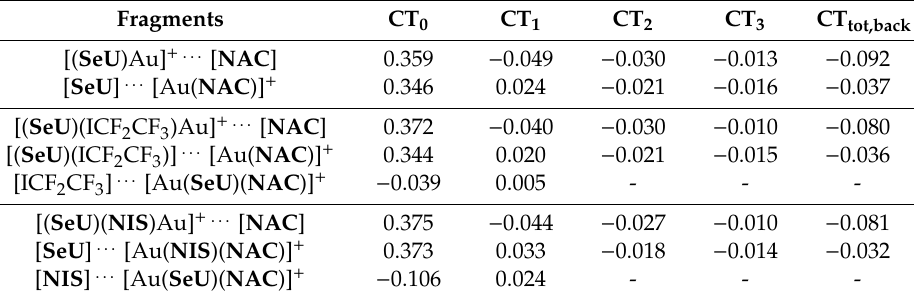
Table 1. NOCV-CD bond analysis results for an organometallic system (charge transfers, CT k , in electrons). Fragments CT